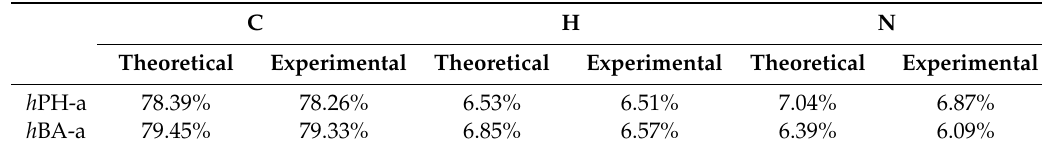
Table 1. Elementary analysis of intermediates. C H N Theoretical Experimental Theoretical Experimental Theoretical